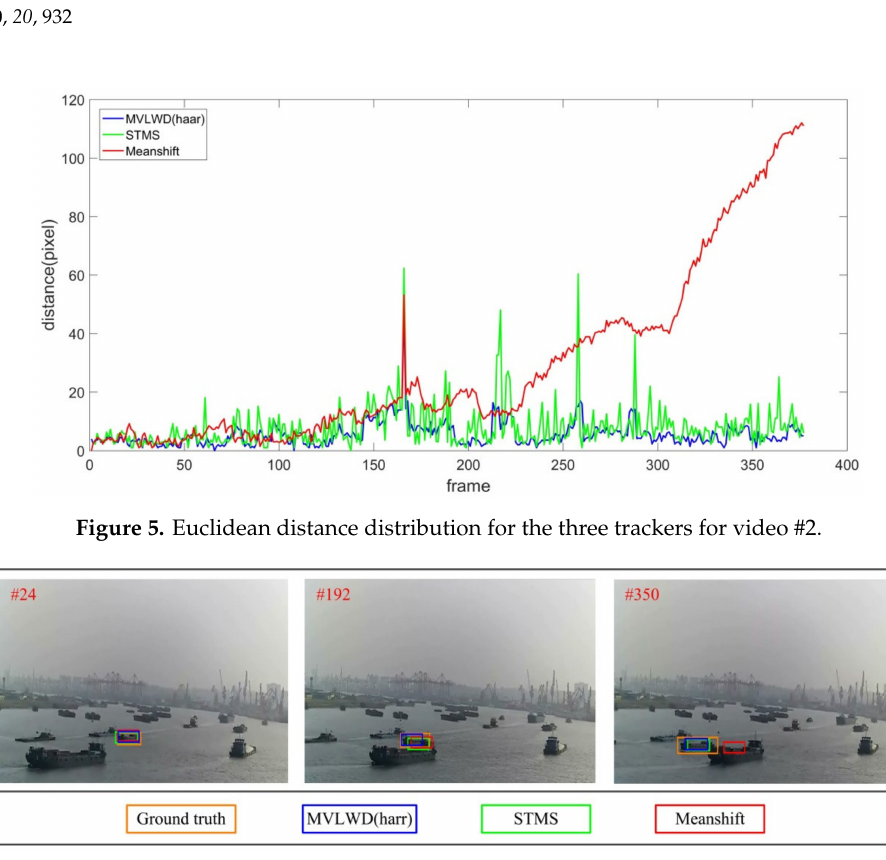
Figure 6. Ship tracking results for the three trackers for typical frames in video #2. Table 2. Statistical performances of the three trackers for video